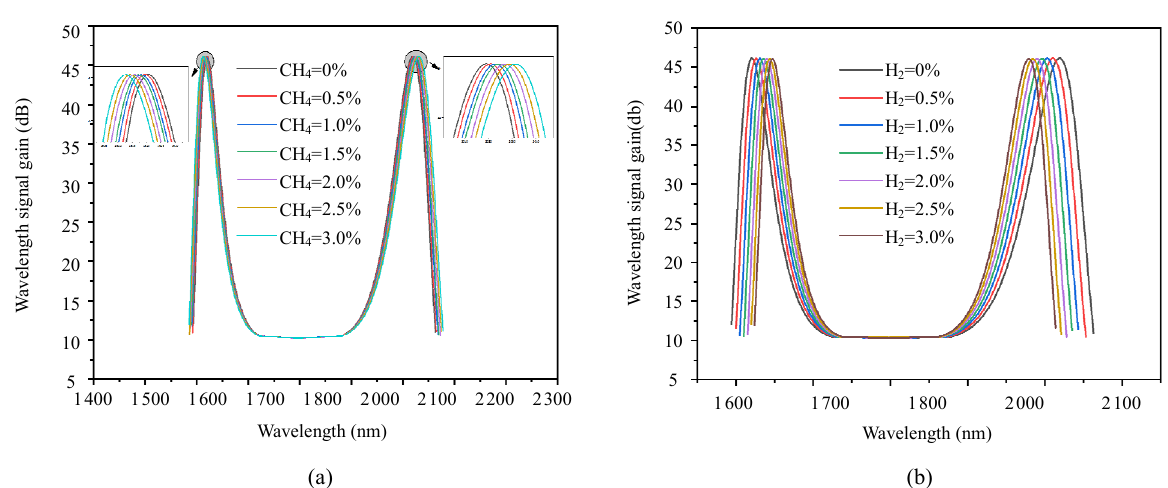
Fig. 9 Stokes and anti-Stokes gain curves affected by gas concentrations under optimal parameters: (a) Stokes and anti-Stokes gain spectrum curves when the methane concentration is 0% − 3% and (b) Stokes and anti-Stokes gain spectrum curves with the variation of the hydrogen concentration.